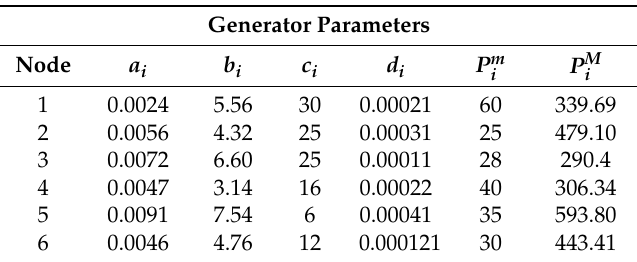
Table 2. Parameters of generators for IEEE 39-BUS [32].